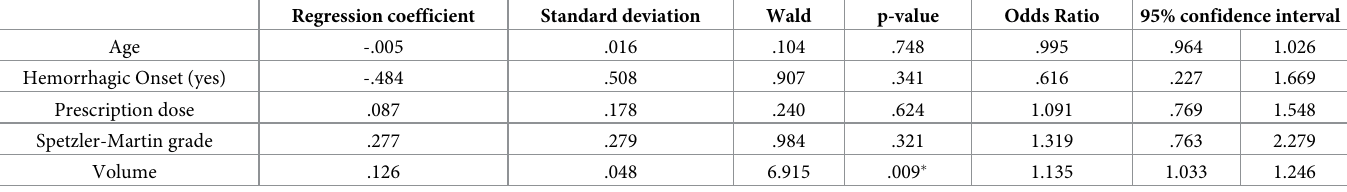
Table 4. Influence of age, hemorrhagic onset, prescription dose and Spetzler-Martin score on the rate of